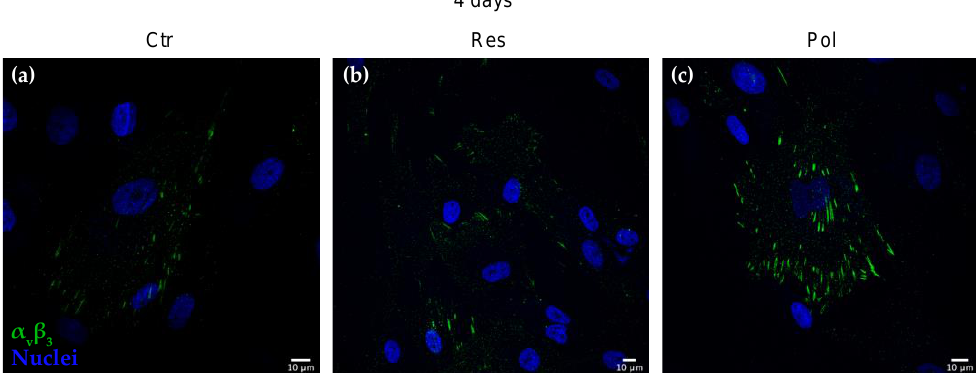
Figure 2. Polydatin (Pol) treatment induces clustering of α V β 3 integrin. Indirect immunofluorescence staining of α V β 3 integrin (green), detected by the antibody LM609, and nuclei (blue) in Dental bud stem cells (DBSCs). Midsection confocal microscopy images show the localization of integrin α V β 3 (green) in cells maintained for 4 days in osteogenic medium and treated with Resveratrol (Res) ( b ), Pol ( c ) and Control (Ctr) ( a ). Images of a representative experiment were chosen for the figure. Scale bar = 10 μm.